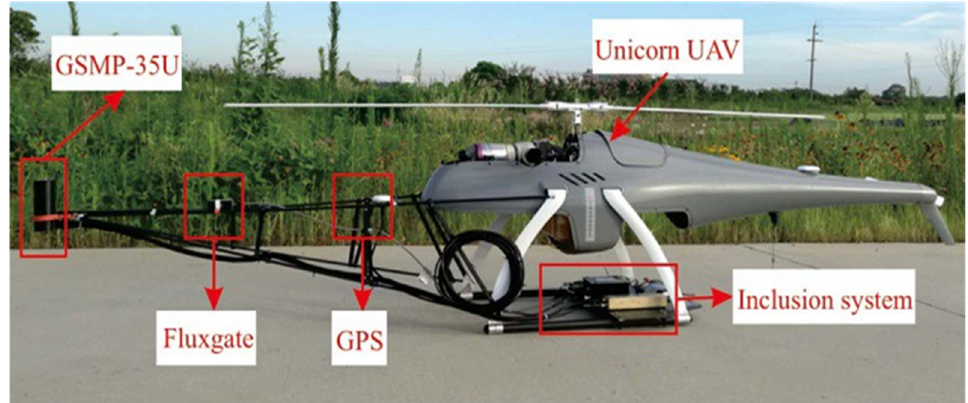
Figure 3. UAV used in FOM flight.